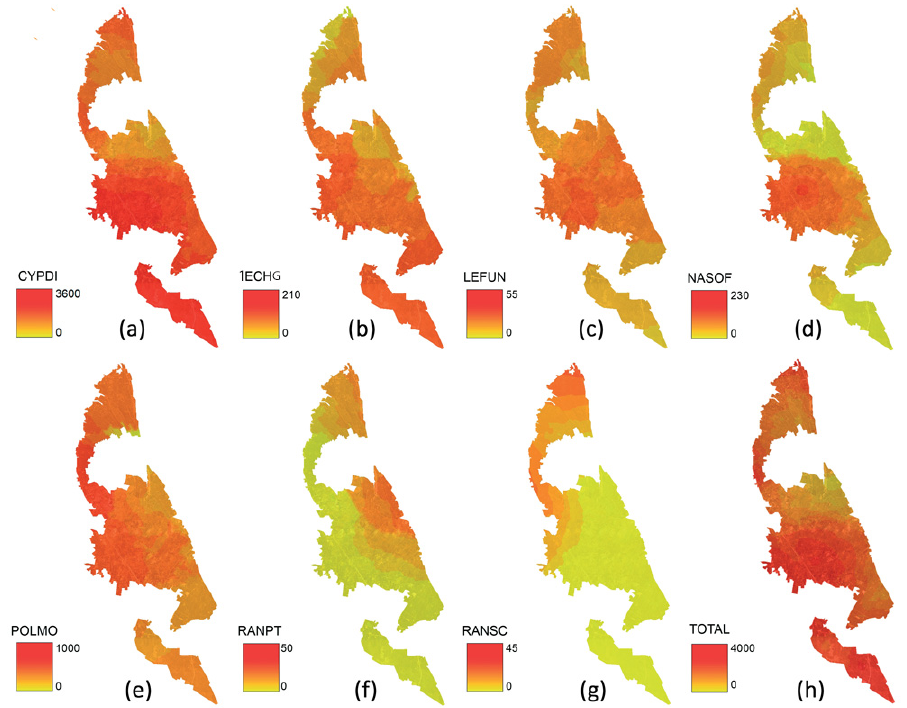
Figure 4. Cartographic representation of the spatial distribution of weed species in the study area: ( a ) Cyperus difformis ; ( b ) Echinochloa complex; ( c ) Leptochloa fusca ; ( d ) Nasturtium oficinale ; ( e ) Polypogon monspeliensis ; ( f ) Ranunculus peltatus ; ( g ) Ranunculus sceleratus; ( h ) all species. Table 5. Effect of the winter flooding level on the total number of germinable seeds and the number of each species in the rice soil seedbank using a concurrent regression model.